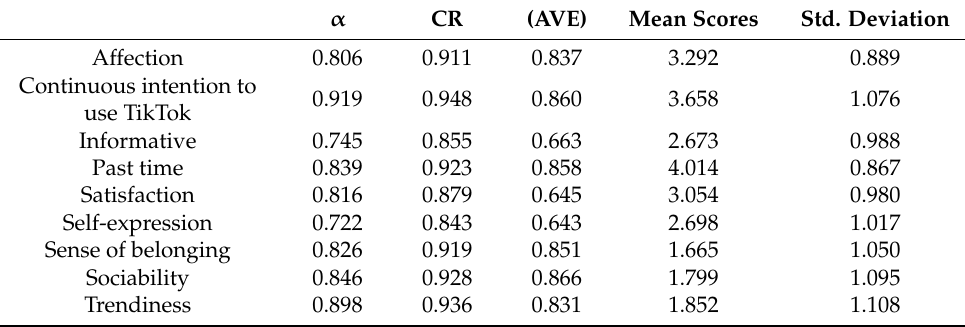
Table 3. Construct Reliability and Validity Analysis (Descriptive